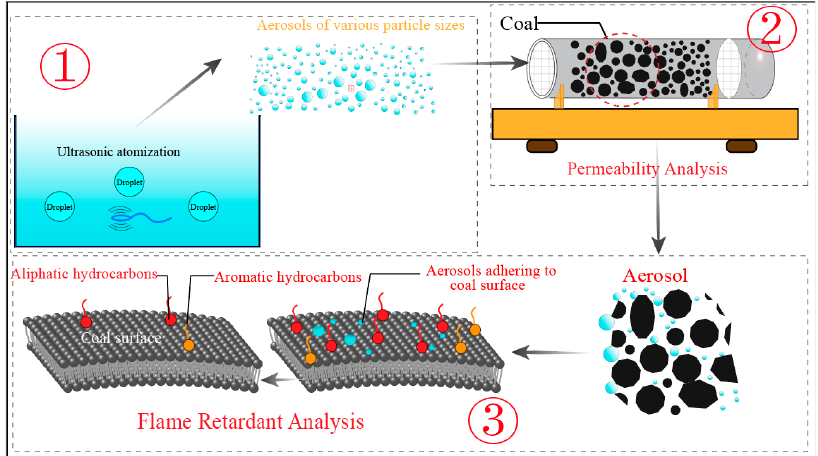
Figure 2. Experimental flow chart. The experiment 1 is the preparation of aerosol; Experiment 2 is aerosol permeability experiment; Experiment 3 is an aerosol flame retardant experiment.